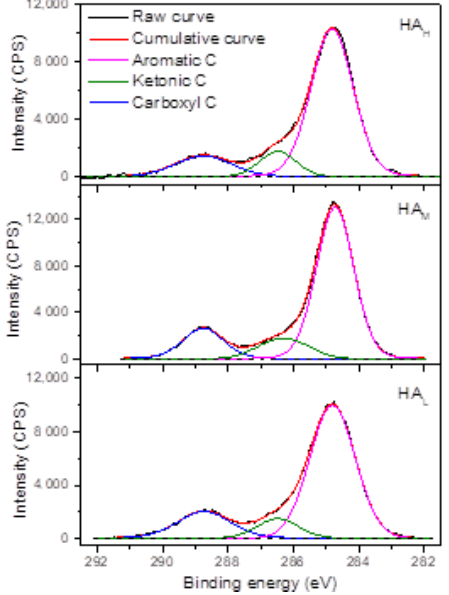
Figure 3. High-resolution C 1 s X-ray photoelectron spectra of HA fractions. The black dash line means the baseline of each sample. Count per second, the intensity unit, is abbreviated as CPS in the